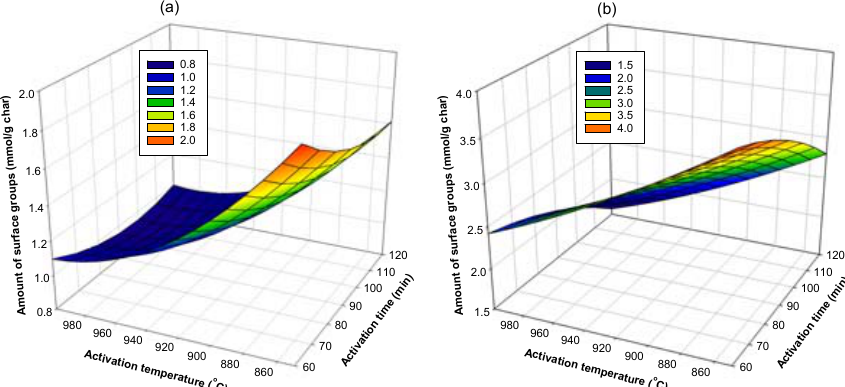
and ( b ) basic groups .